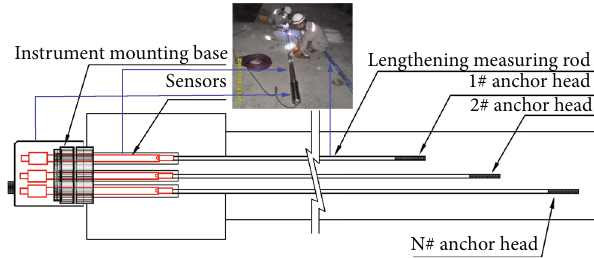
Figure 2: Multipoint displacement meter structural diagram (left) and on-site installation